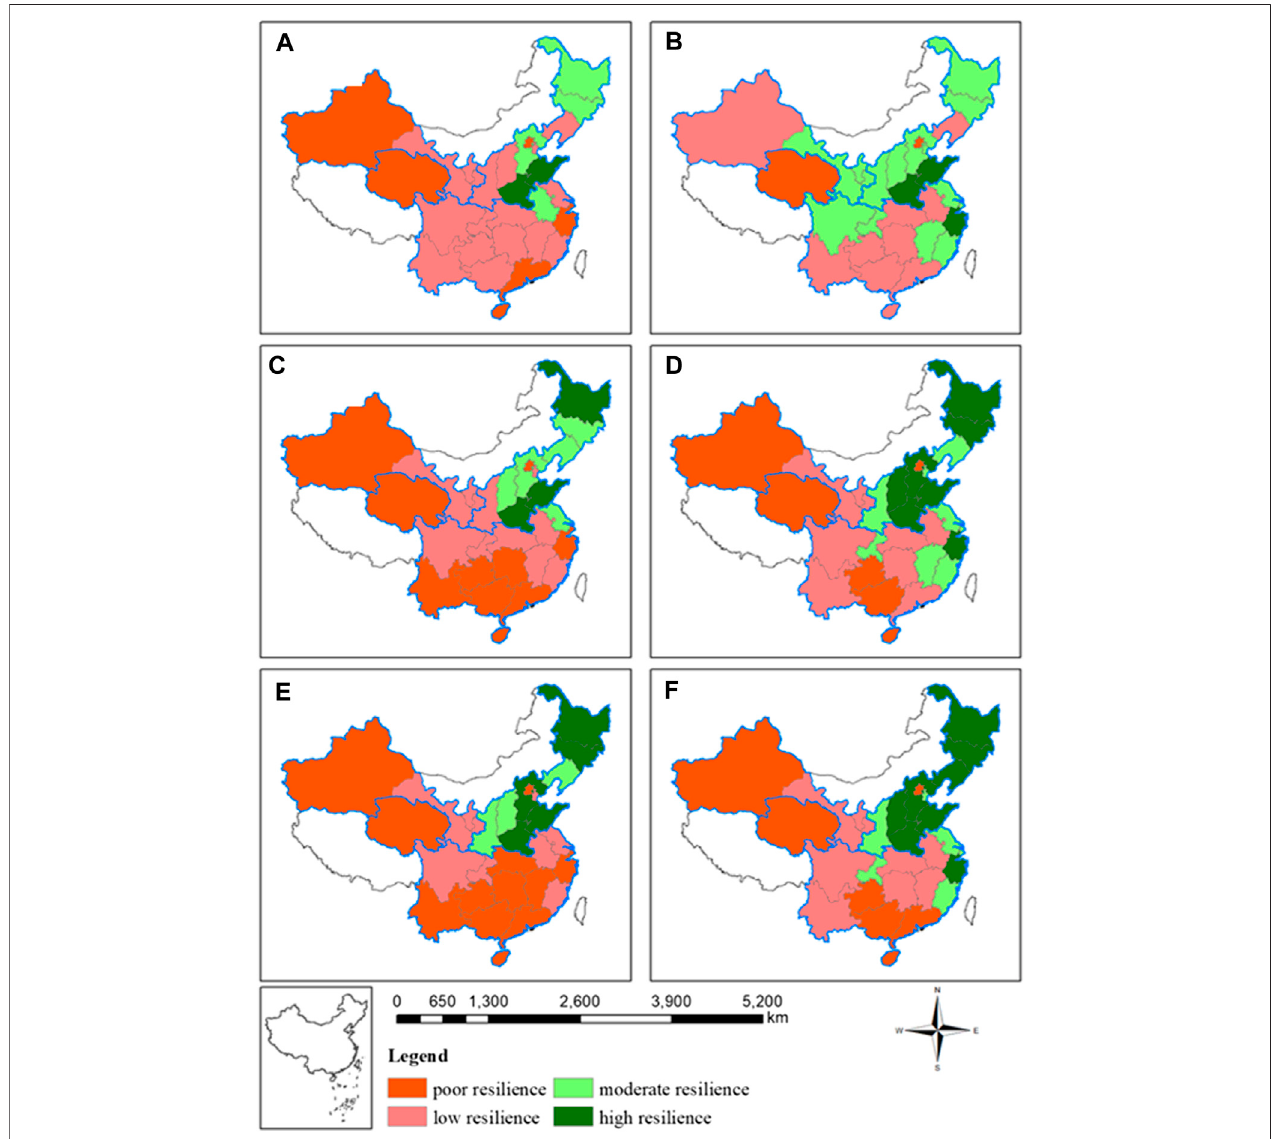
FIGURE6| Resilienceassessmentforgrainunityieldunderdifferentscenarios; (A) 2035SSP1 – 2.6, (B) 2050SSP1 – 2.6, (C) 2035SSP2 – 4.5, (D) 2050SSP2 – 4.5, (E) 2035 SSP5 – 8.5, and (F) 2050 SSP5 – 8.5.